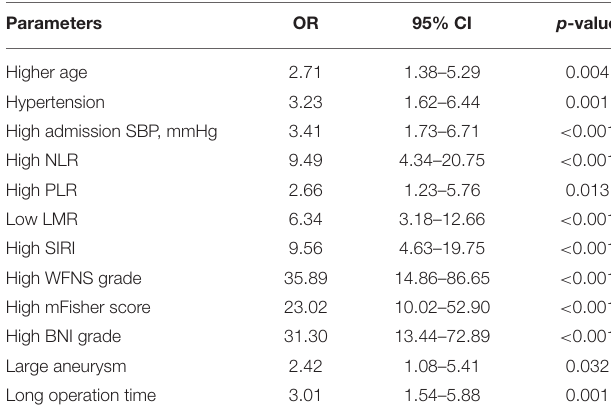
TABLE 3 | Univariable logistic regression analysis of postoperative tracheostomy with possible predictive factors in training cohort.